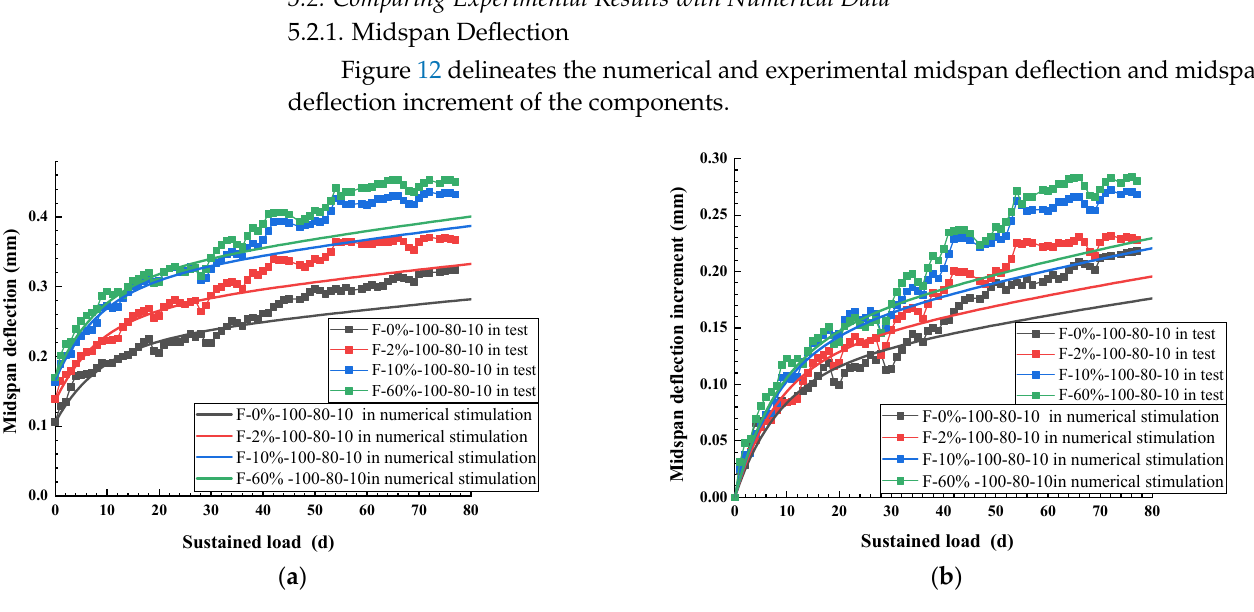
Figure 12. The evolution of the ( a ) midspan deflection and ( b ) midspan deflection increment during fatigue loading.